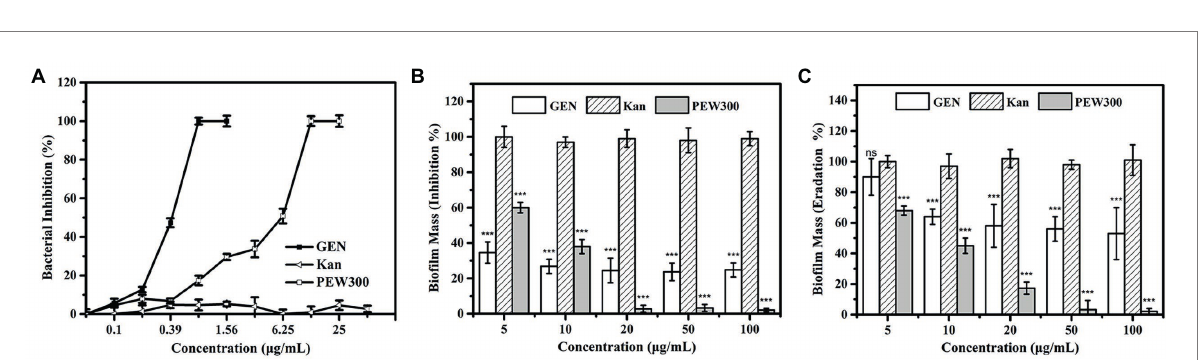
FIGURE 3 Antibacterial and antibiofilm properties of PEW300. (A) Antibacterial activity of PEW300, kanamycin (Kan), and gentamicin (GEN) against Pseudomonas aeruginosa JCM5962. (B) Inhibition and (C) dispersion activity of PEW300 against P. aeruginosa JCM5962 biofilms. Error bars represent standard error from mean values as determined by three repeated experiments, *** indicates p < 0.005 and ns means no significant difference compared with Kan-treated